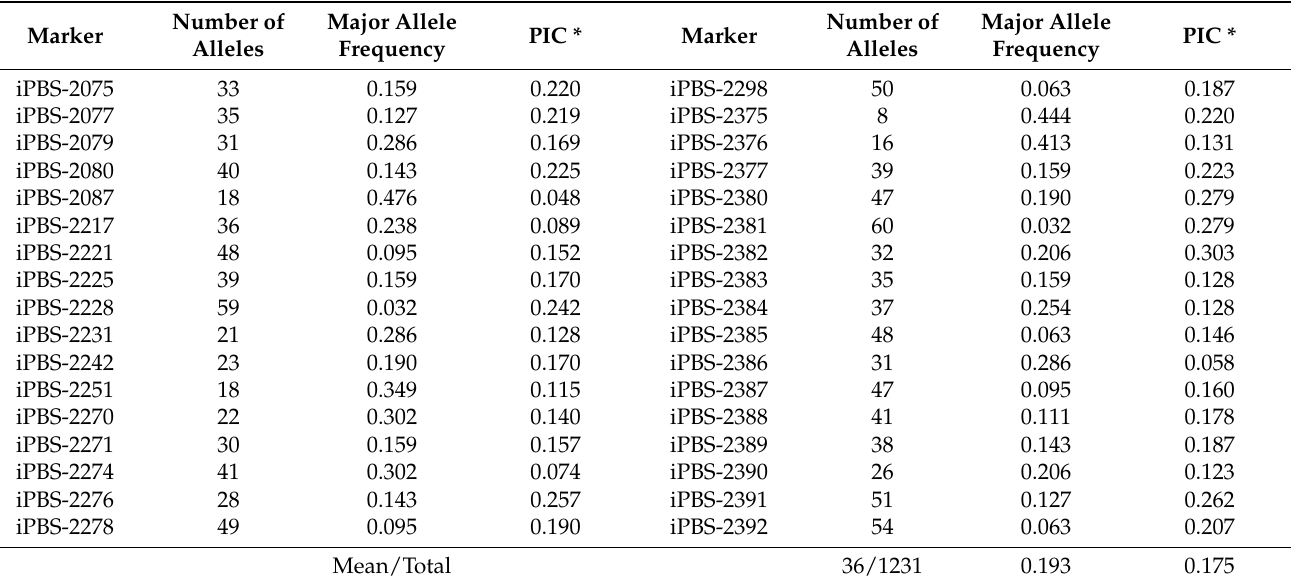
Table 3. Thirty-four iPBS primers used in the detection of polymorphism among 63 wheat varieties ( Triticum aestivum L.).